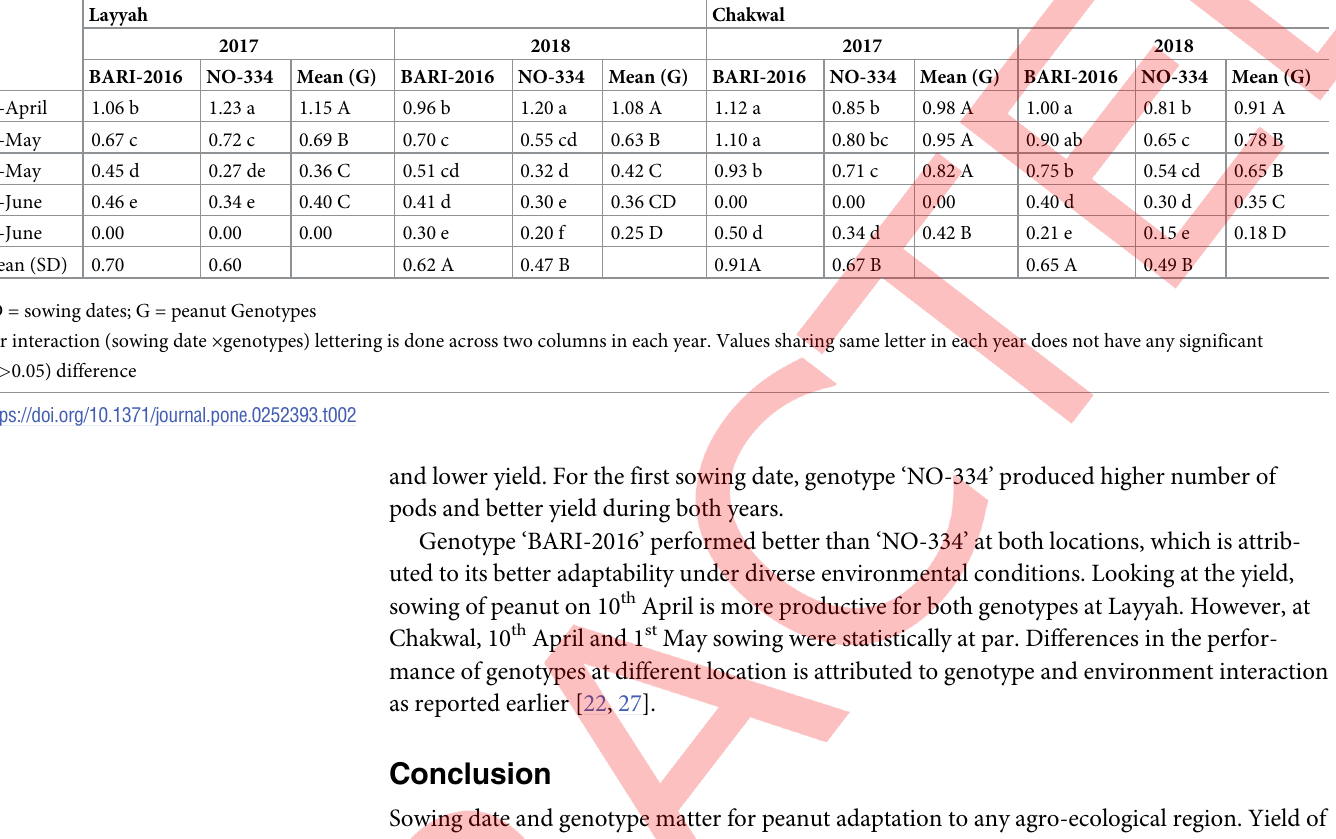
S1 Table. Weather data during the both experimental year at Chakwal and Layyah site. (DOCX)